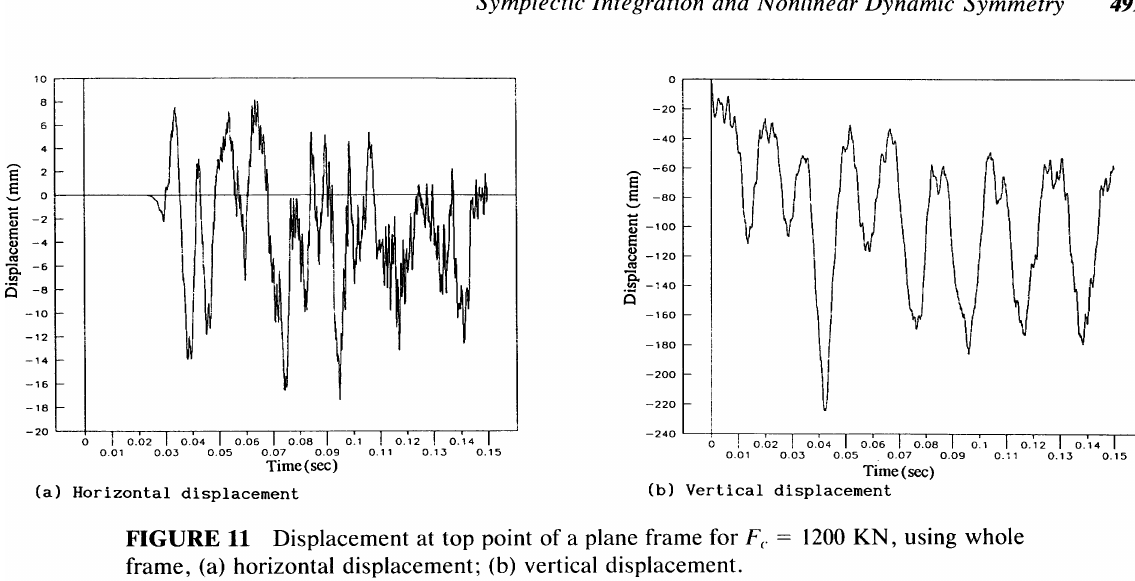
FIGURE 11 Displacement at top point of a plane frame for Fe = 1200 KN, using whole frame, (a) horizontal displacement; (b) vertical displacement.